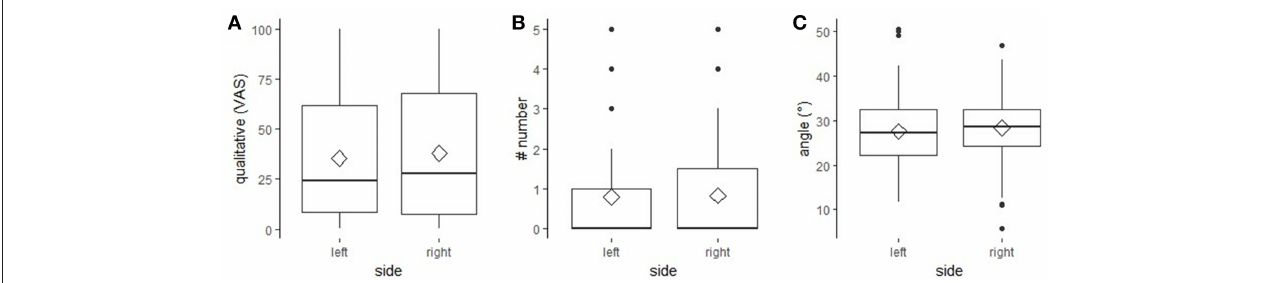
FIGURE 3 | Effect of “side” on the three outcome measures. The effect of “side” (left, right) on the outcome measures “qualitative assessment” assessed on a Visual Analogue Scale (A) , “number” of wrinkles (B) and “angle” measured in degrees (C) . (A–C) boxplots with median (black line), mean (diamond), interquartile range (box), 1.5 × interquartile range